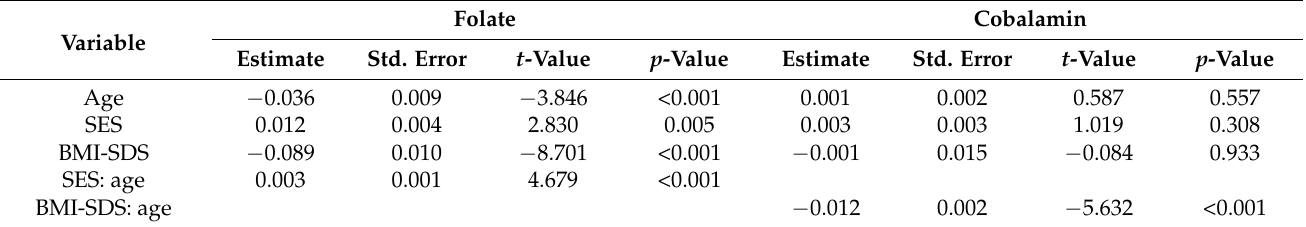
Table 2. Multivariate regression analysis results: age, body mass index (BMI), and socioeconomic status